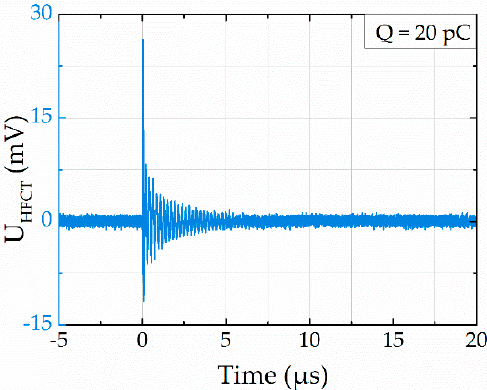
Figure 7. The response of the high ‐ frequency current transformer (HFCT) at a PD magnitude of 20 pC.